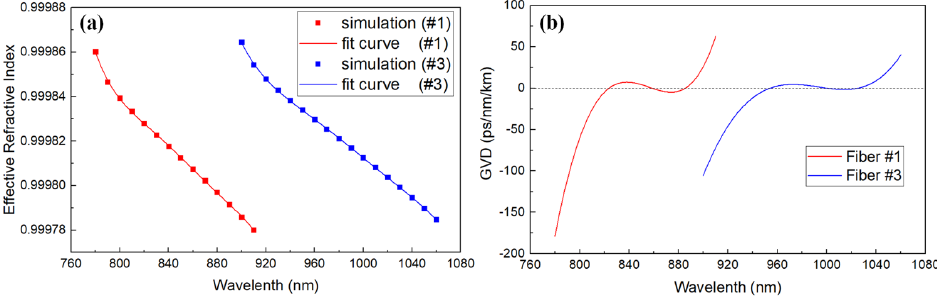
Figure 5. ( a ) Effective refractive index and ( b ) GVD (Group Velocity Dispersion) curve of both Fiber #1 and #3. In ( a ), the dots plot the simulation values, while the solid curves are quintic functions, which fit the simulation values.